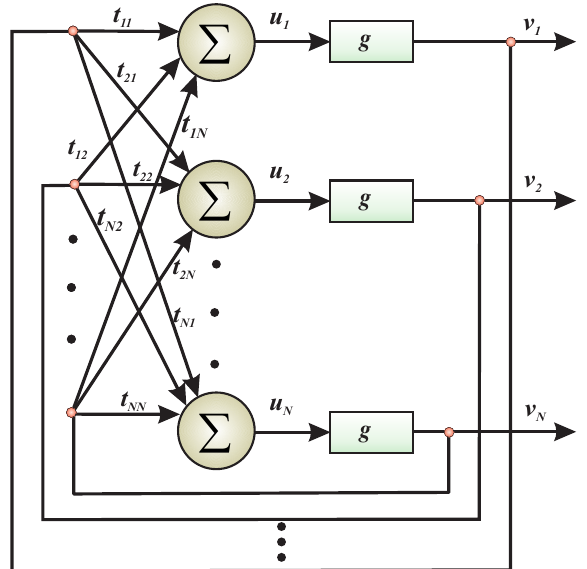
Figure 10. The structure of the Hopfield-like continuous neural network. In the picture, t ik is an interconnection strength between the neuron i and k , u i is internal potential of neuron i , and g is a continuous activation function (usually sigmoidal) with given external potentials v i = g ( u i )